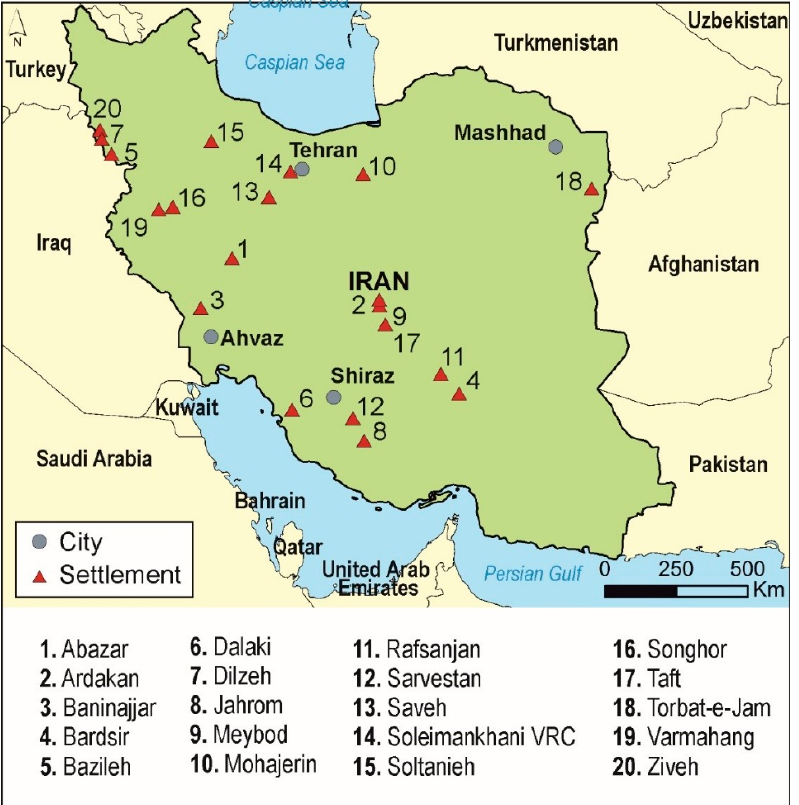
Figure 1. Guest towns in Iran. The case study areas are Bani Najjar (3), Bardsir (4), Rafsanjan (11), and Torbat-e-Jam (18) GT. Source: Adapted from [52].